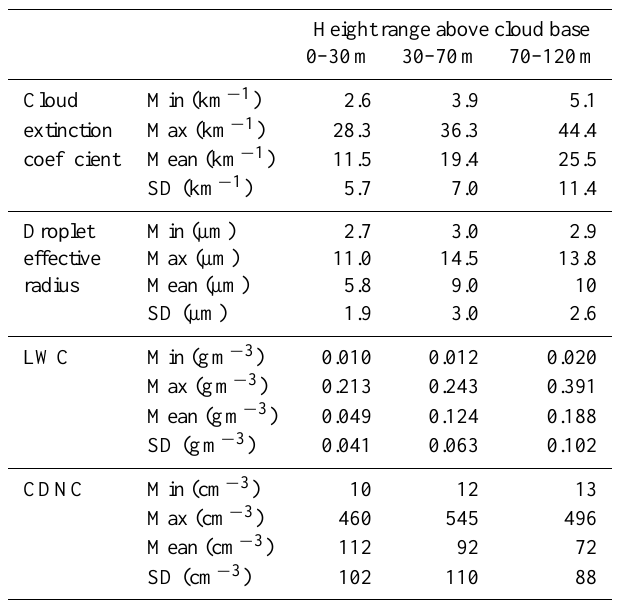
Table 3. Statistics of cloud extinction coefficients (532nm), droplet effective radii, LWCs, and CDNCs, derived from the dual-FOV Ra- man lidar observations. Range of values (minimum to maximum), mean values, and standard deviations (SD) are presented.